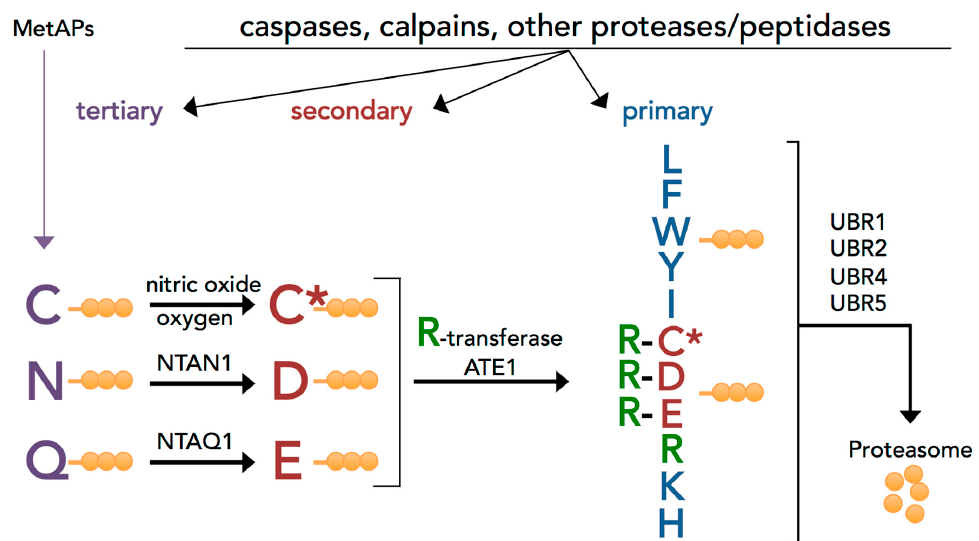
Figure 1. The mammalian Arg / N-degron pathway. N-terminal residues are indicated by single-letter abbreviations for amino acids, and the rest of a protein substrate is represented by orange spheres. “Primary”, “secondary”, and “tertiary” denote mechanistically distinct subsets of destabilizing N-terminal residues. C* denotes oxidized N-terminal Cys, either Cys-sulfinate or -sulfonate. The mammalian N-recognins UBR1, UBR2, UBR4, and UBR5 (EDD) have multiple substrate-binding sites